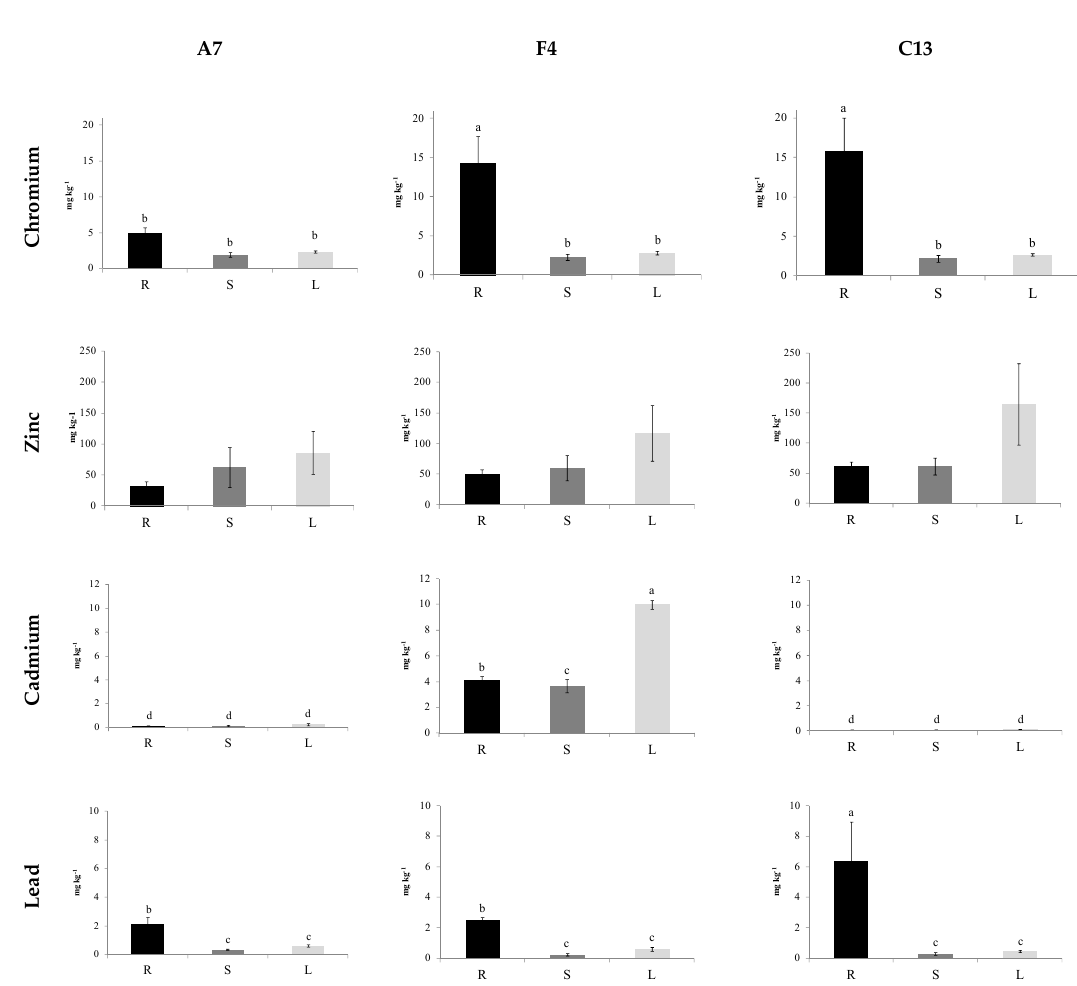
Figure 1. PTEs concentrations (mg kg − 1 dry weight) in roots (R), shoots (S) and leaves (L) of Indian mustard cultivated in mesocosms on the three studied soils (average of the three repeated croppings). (different letters indicate significant differences between the plant tissues in a given soil, for p < 0.05). Error bars represent standard deviations.